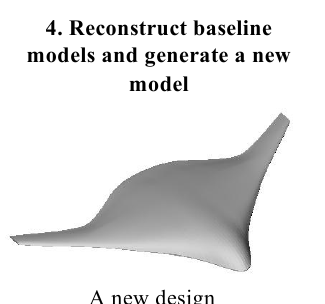
Figure 3. The diagram of the flattening-based morphing method. After the anchor points have been defined on the baseline models, the baseline meshes are mapped to the parametric space by matching the location of the anchor points with their counterparts. Then, the mapped baseline meshes are remeshed to make them topologically the same. The remeshed baseline models are parameterized back to the physical space, and a new morphed model is created by interpolating the configuration of the remeshed baseline models. Here, for BWB morphing, the upper and lower sides of the BWB are separately mapped to the parametric